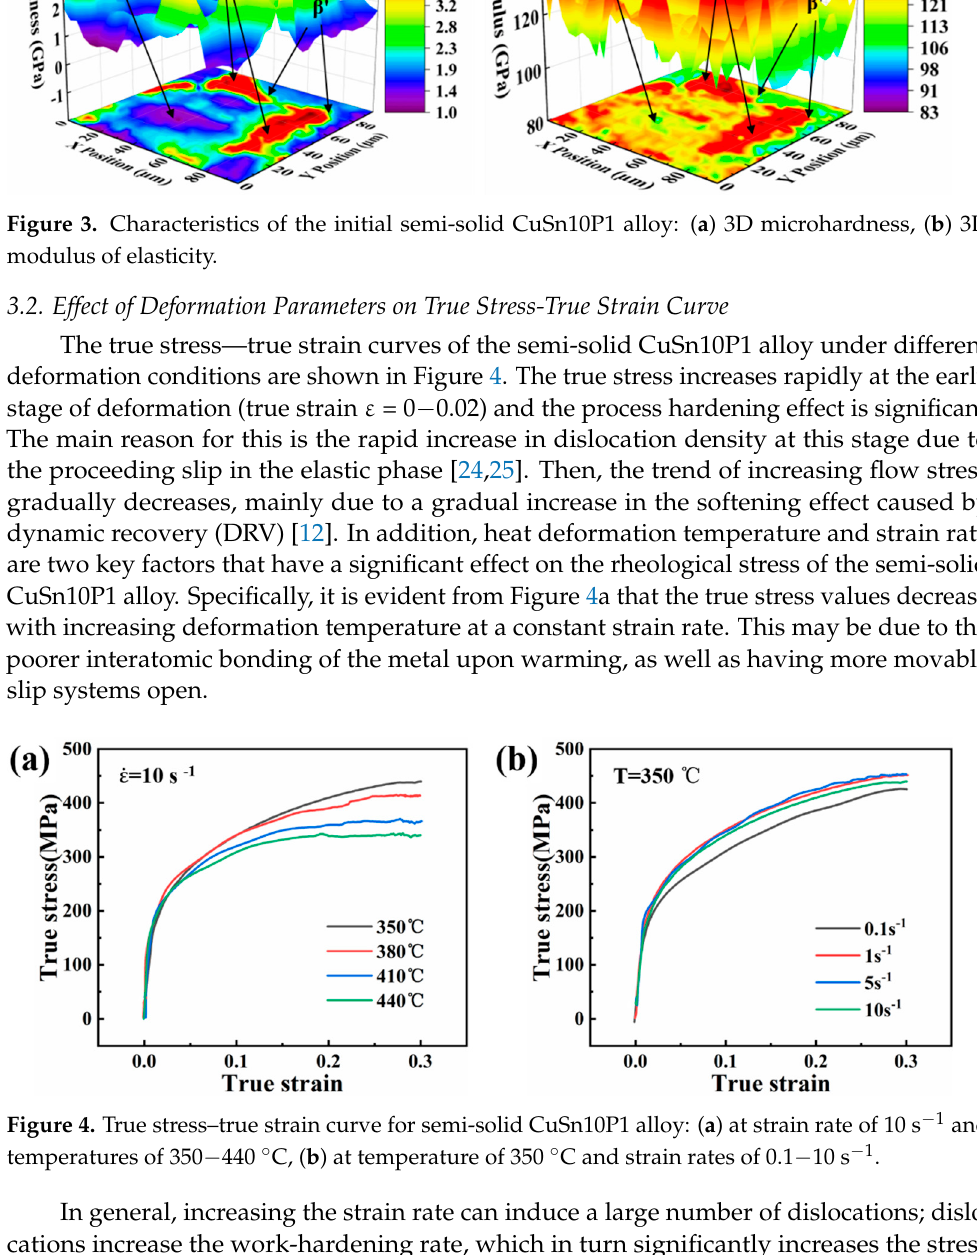
Figure 5. Stress distribution clouds for semi-solid CuSn10P1 alloy copper at different levels of com- pressive deformation: ( a ) ε = 0.1, ( b ) ε = 0.2, ( c ) ε = 0.3. Figure 6 shows the microstructure of the semi-solid CuSn10P1 alloy at a strain rate of 10s − 1 and a temperature of 350 °C with different true strains. As shown in Figure 6a, no filamentary deformation sign was observed in the SEM images at a true strain ε = 0. As shown in Figure 6b, when the true strain increases to 0.1, a small number of parallel fila- mentary deformation marks is found in the area indicated by the red arrow. From the transmission data in Figure 6, it is clear that these filamentary deformation marks are a combination of dislocations, layer dislocations and deformation twins. The faster corro- sion rate in corrosion, due to the higher energy of dislocations, laminations and defor- mation twin regions, is revealed in the grains. At a true strain of ε = 0.2, the filamentary deformation marks in the grain start to cross as shown in Figure 6c. This may be caused by the dislocations meeting the forward extension of the stacking faults after increasing the strain. Finally, as shown in Figure 6d, when the true strain ε = 0.3, some of the filamen- tary deformation marks have extended into the grain interior. This is mainly due to the